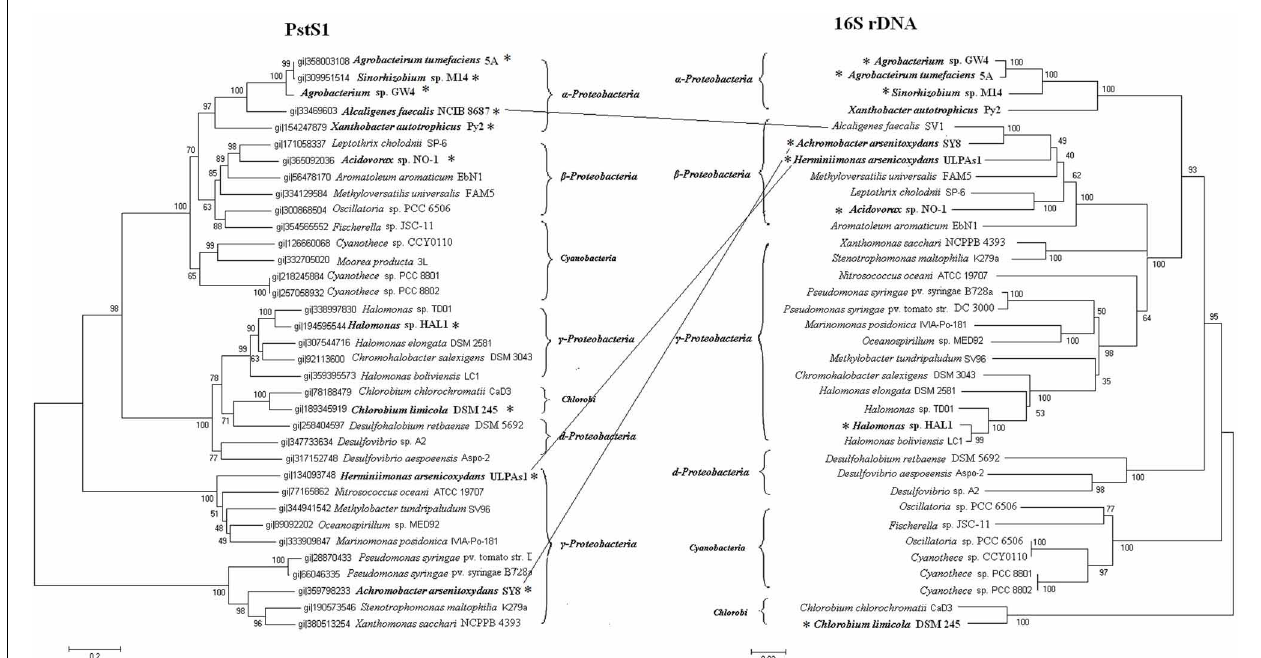
FIGURE 3 | Phylogenetic trees based on PstS1 sequences and 16S rDNA sequences. Bold and *symbol represent proteins from the strains of the arsenic islands while the others are not. Putative horizontal gene transfer